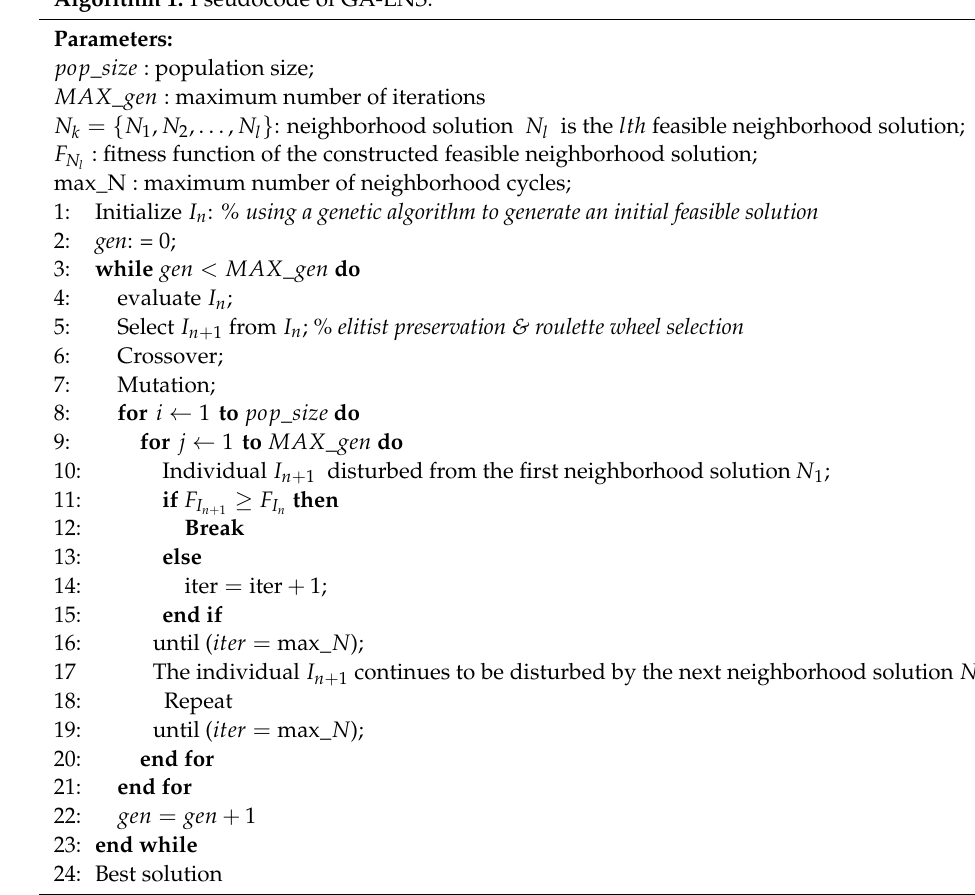
Algorithm 1: Pseudocode of